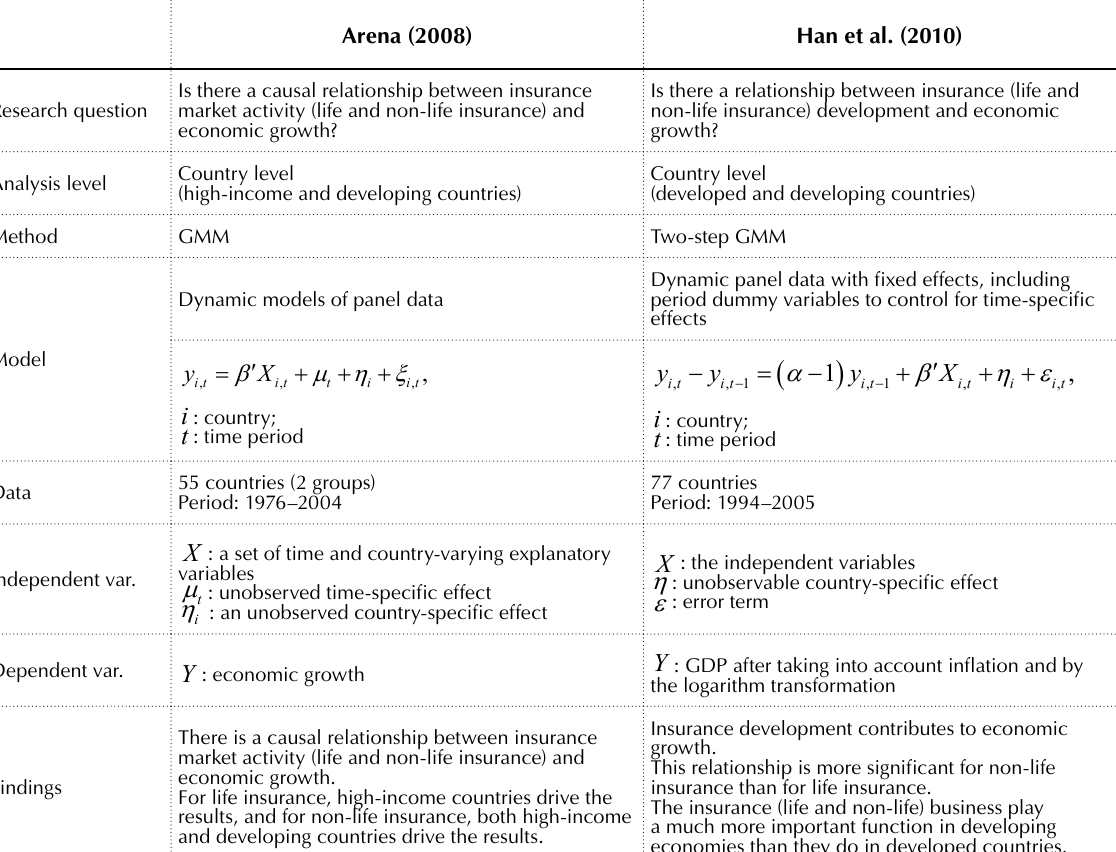
Table 1. Comparison between Arena (2008) and Han et al. (2010) Arena (2008) Han et al. (2010) Research question Analysis level Method GMM Two-step GMM Dynamic panel data with fixed effects, including Dynamic models of panel data period dummy variables to control for time-specific Model